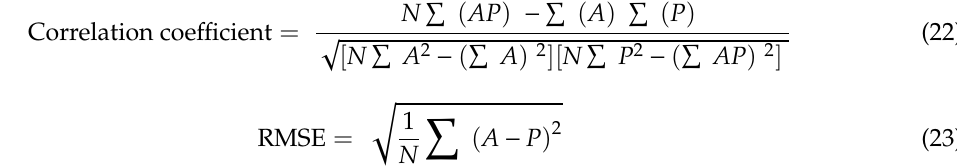
Table 3. Accuracy statistics for the logistic model.